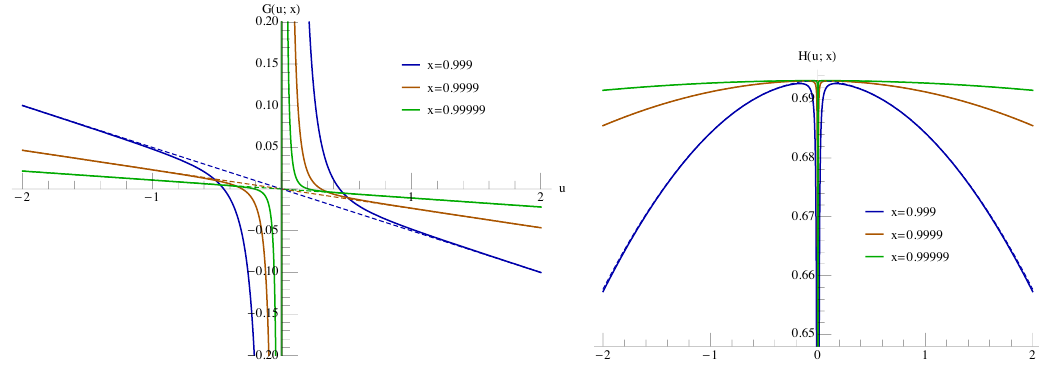
Figure 4 . Detailed structure of some relevant integral kernels. Left: this panel shows the evaluation of the function G de(cid:12)ned in (3.10) and evaluated with (cid:20) = 1. The plot shows that the kernel is composed of a linear background plus a singular part which is localized in a region of width (cid:24) (1 (cid:0) x ) 2 = 3 and approximates, as a distribution, a (cid:14) 0 contribution. Right: this panel shows the evaluation of the function H de(cid:12)ned in (3.20). Similar to the left panel, we identify in the x ! 1 limit a quadratic background plus a narrow (cid:14) like contribution fully discussed in the